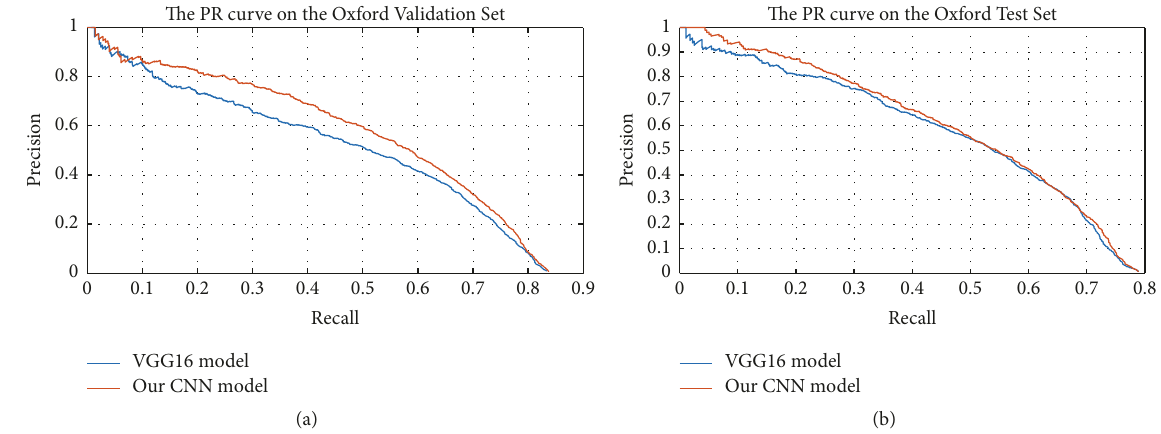
Figure 6: Precision-Recall curve on the Oxford dataset: (a) validation set; (b) test set.